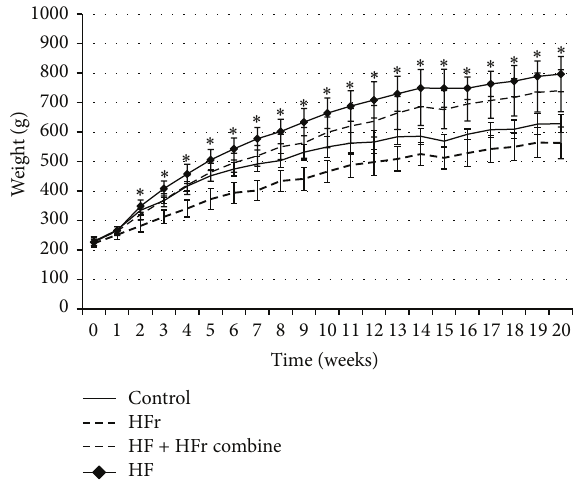
Figure 1: Changes in body of rats fed control, high-fat, high- fructose, and combination diet groups for the indicated weeks ∗ 𝑝 < 0.05 by